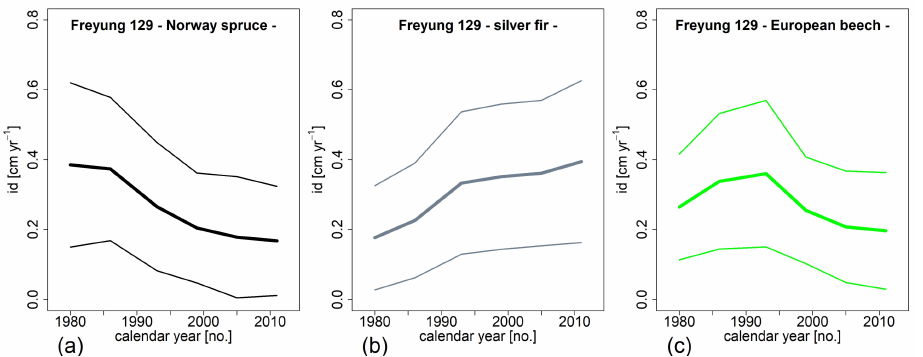
Figure 3. Periodical mean annual stem diameter growth (mean ± standard deviation) of ( a ) Norway spruce, ( b ) silver fir, and ( c ) European beech from 1980–2018 on all plots (FRY 129/11, 12, 21, 22, 31, and 32) of the selection forest experiment Freyung 129. Growth rates plotted over calendar year at the start of the respective survey period, i.e., the growth plotted over 1980 refers to the period 1980–1985, the growth plotted over 2011 refers to the period 2011–2018.